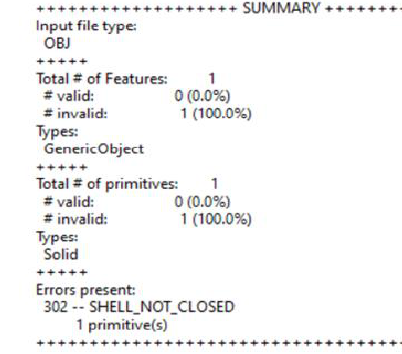
Figure 5. Report of geometry validation shows an error existed in the model.